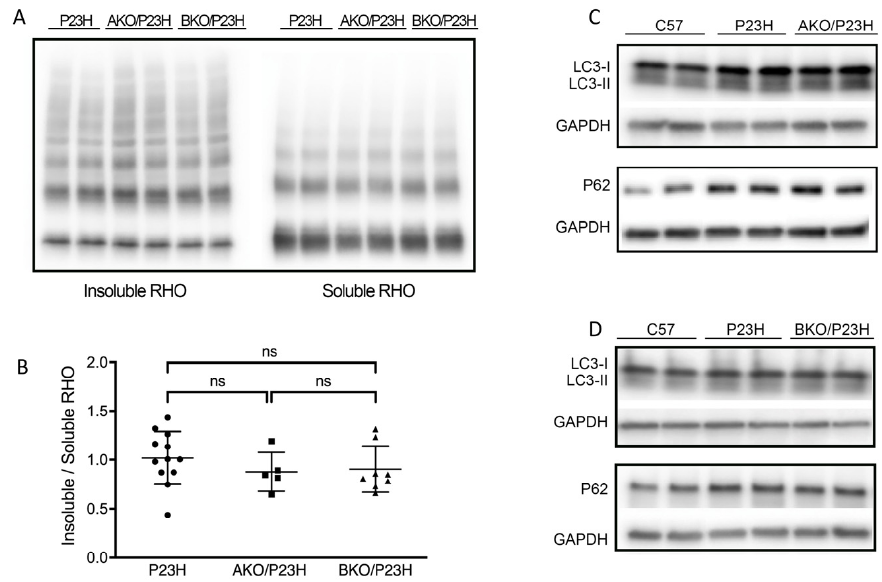
Figure 5. There is no change in the level of soluble P23H-rhodopsin or autophagic activity in the AKO/P23H and BKO/P23H mouse retina. ( A ) Representative western blots probed for rhodopsin (RHO) in the soluble and insoluble fraction of total retinal protein from AKO/P23H, BKO/P23H and P23H mice at the age of two months. ( B ) Quantification of western-blot bands of the ratio of insoluble RHO to soluble RHO. ( C ) Representative western blots probed for LC3 and SQSTM1/p62 and GAPDH in the retina of AKO/P23H, ( D ) BKO/P23H, P23H and C57 mice. For better detection of autophagy flux, mice received an intraperitoneal injection of leupeptin (40 mg/kg body weight) 4 h before sampling. (n ≥ 5), ns, not significant. One-way ANOVA.